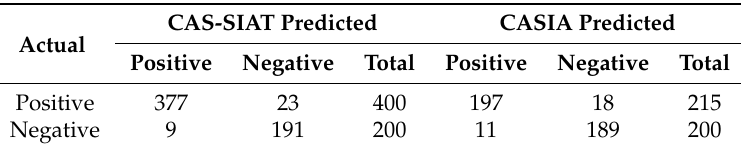
Table 3. Confusion matrix for the network trained with the CAS-SIAT-Iris dataset and and tested with both datasets.